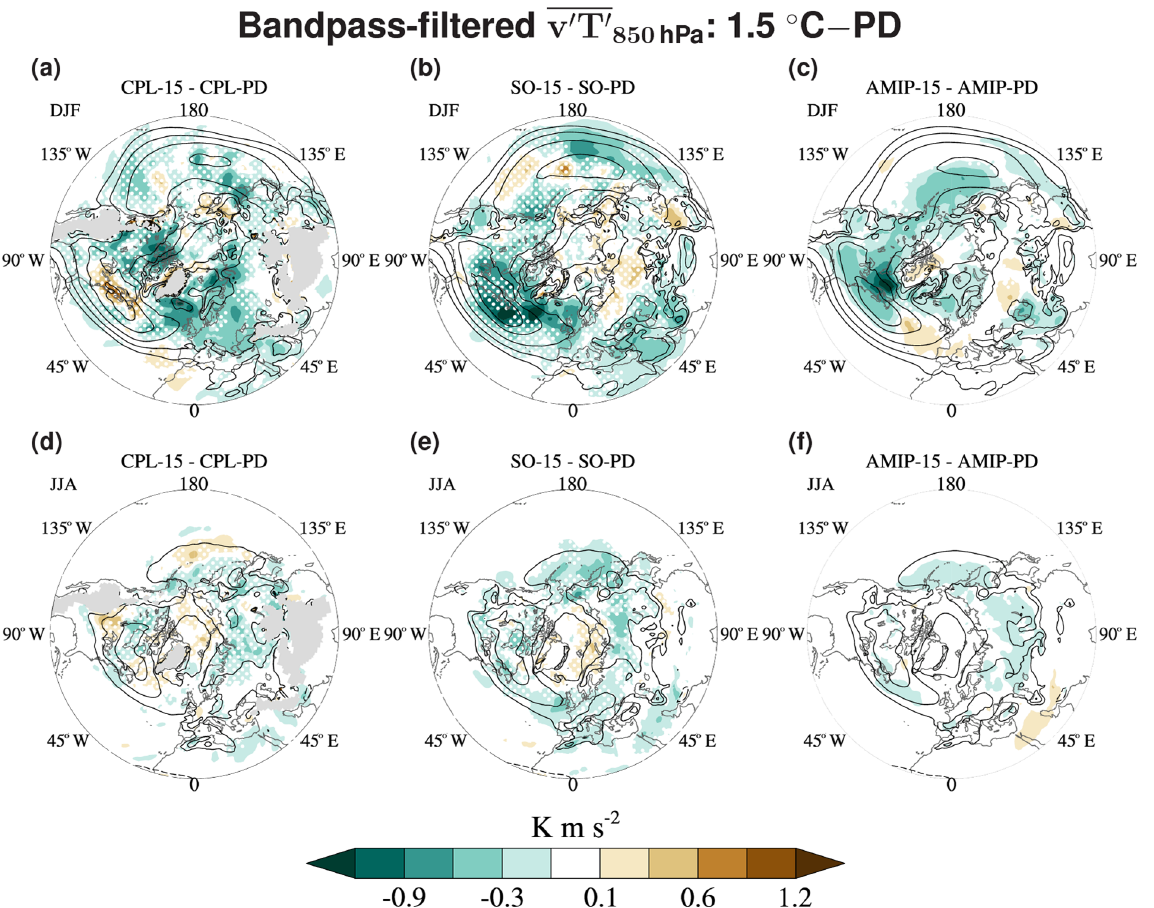
Figure 15. Changes in the low-level storm-track activity relative to PD (colours) and PD climatology (black contours; − 12 to 12Kms − 2 in increments of 4Kms − 2 ) for the 1.5 ◦ C experiment from NorESM1-Happi (a, d) , NorESM1-HappiSO (b, e) , and NorESM1- HappiAMIP (c, f) for DJF (a–c) and JJA (d–f) . The storm tracks are represented in terms of the bandpass-filtered eddy heat flux v (cid:48) T (cid:48) at 850hPa. The white dots indicate that the differences are not significant at the 5% level according to the Welch t test. The fields are shown for the default periods given in Sect. 3. Units are in Kms − 2 (a–f)